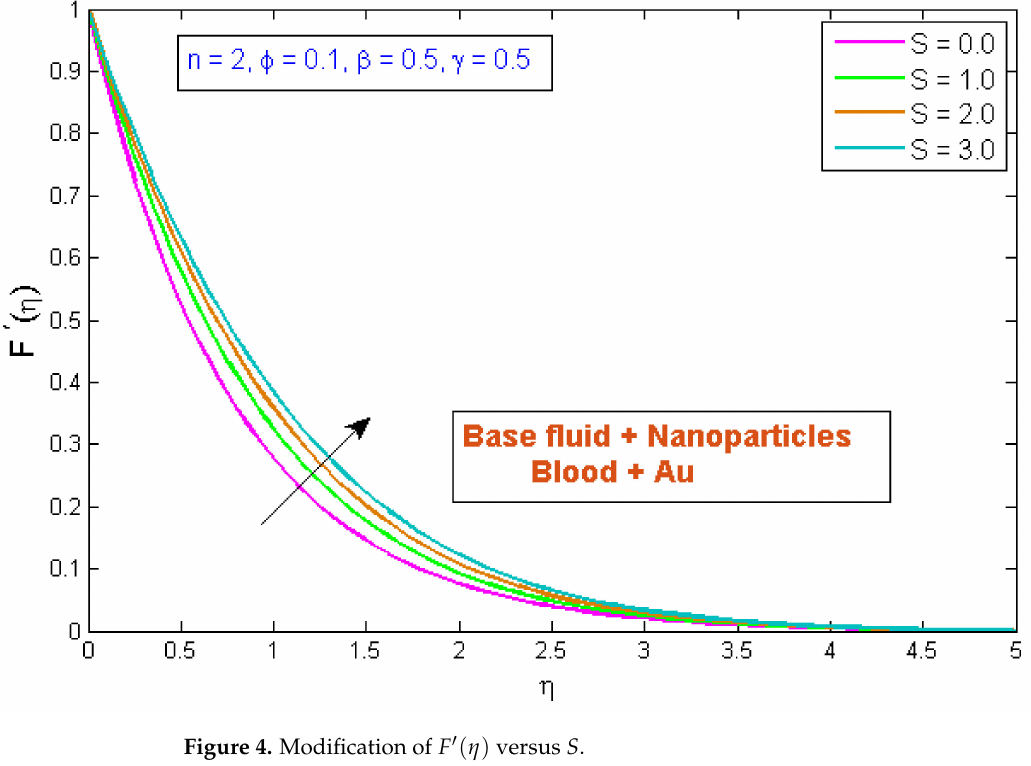
Figure 4. Modification of F (cid:48) ( η ) versus S .